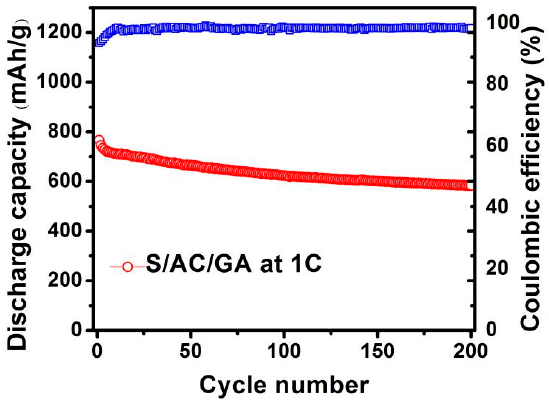
Figure 10. Prolonged cycling performance of S/AC/GA composite electrode at a high rate of 1 C at a potential range of 1–3 V.